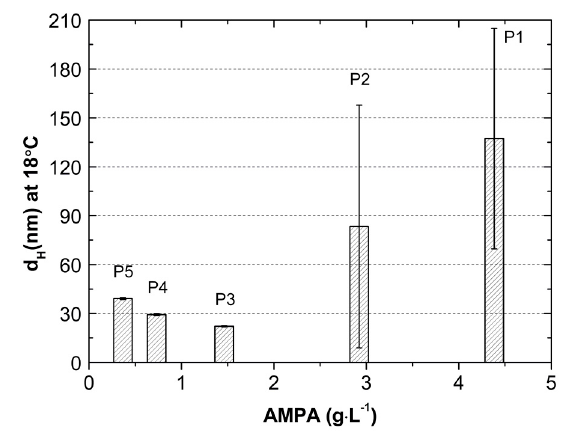
Figure 13. Particles sizes of prepared NVCL polymers P1, P2, P3, P4, and P5 as a function of the concentration of cationic initiator 2,2’-azobis[2-methylpropionamidine] dihydrochloride (AMPA).